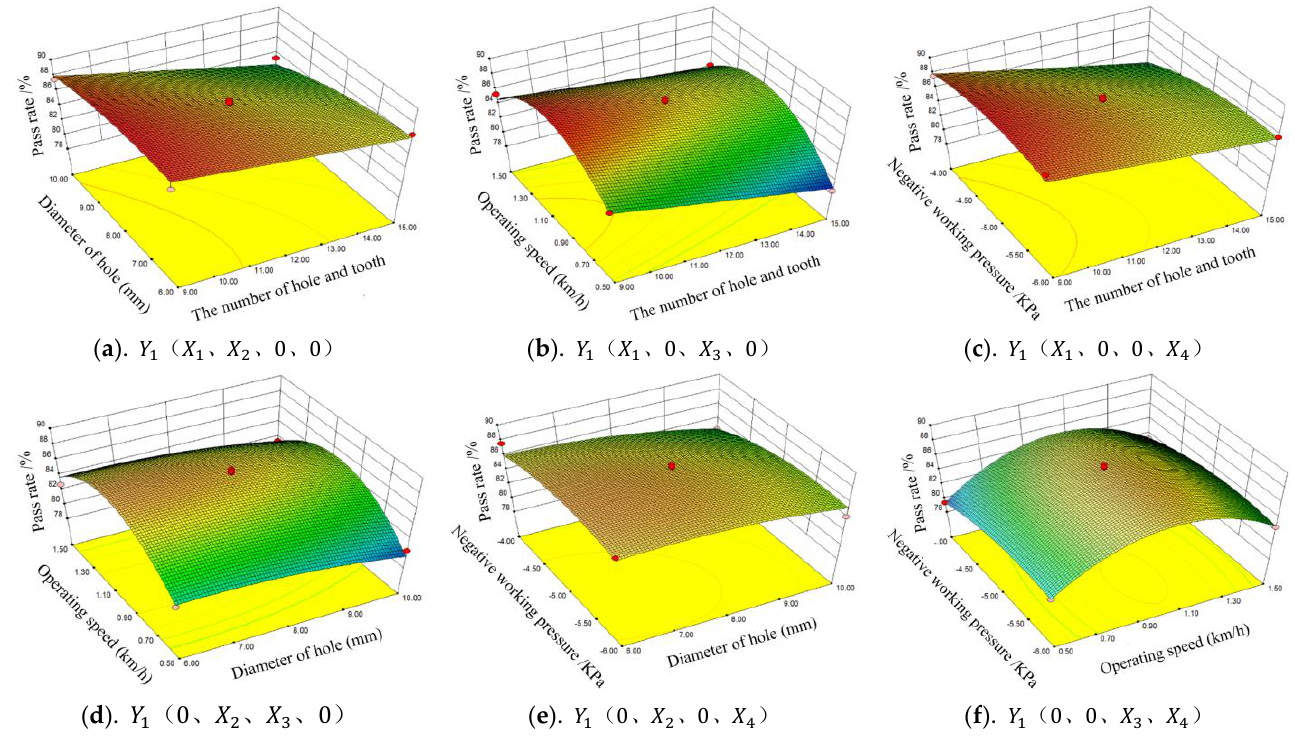
Figure 15. Influence of various factors on qualified seeding rate.